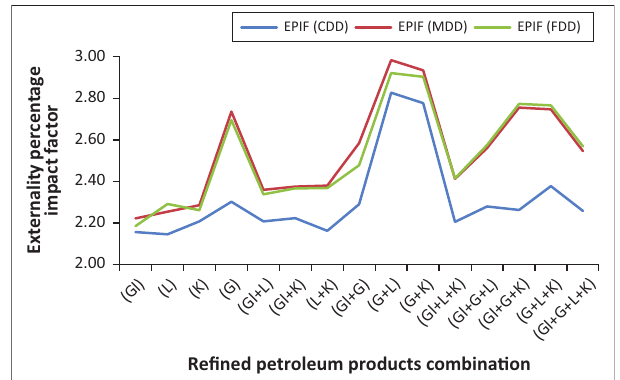
FIGURE 4: Externality percentage impact factor